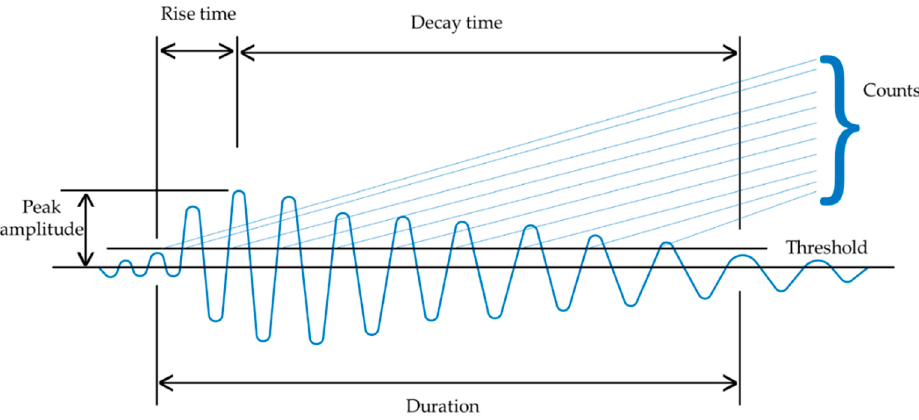
Figure 2. A pictorial representation of the considered AE features.